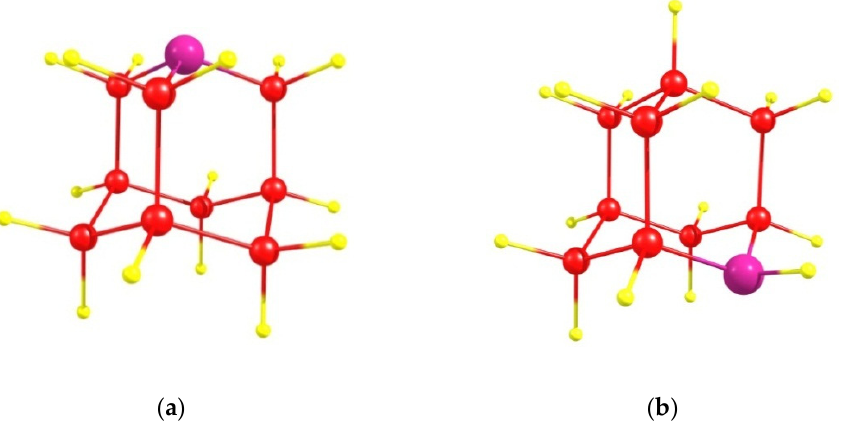
Figure 1. Azaadamantane molecules: ( a ) 1-azaadamantane molecule (4 equivalent positions for the N atom) and ( b ) 2-azaadamantane molecule (6 equivalent positions). Nitrogen atom is shown in purple, carbon atoms–in red and terminating hydrogen atoms–in yellow.